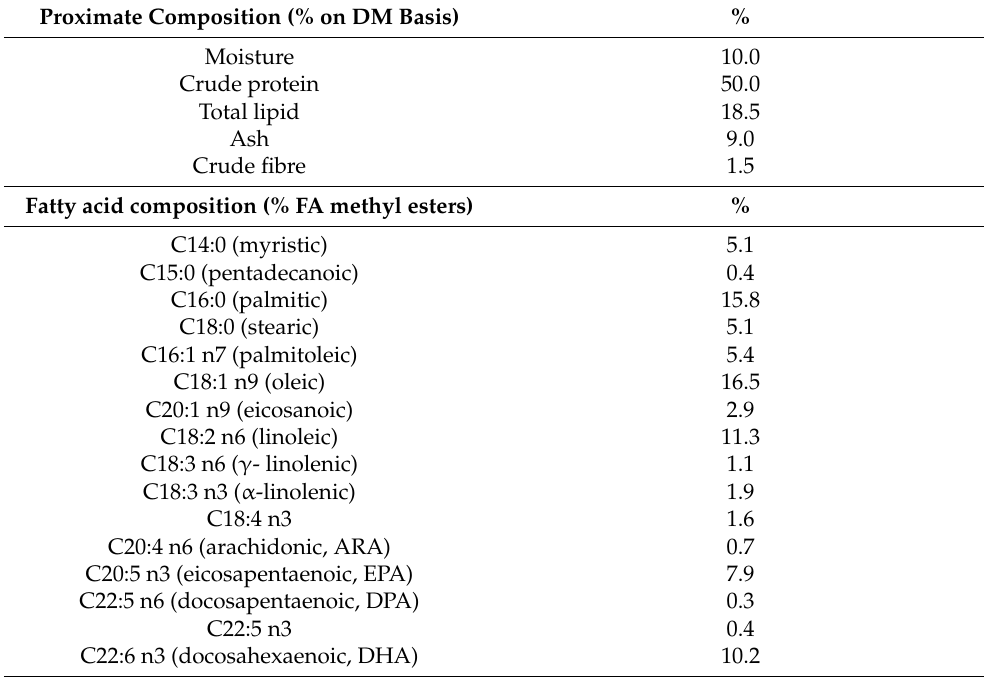
Table 1. Chemical and fatty acid composition of feed (%). Proximate Composition (% on DM Basis) % Moisture 10.0 Crude protein 50.0 Total lipid 18.5 Ash 9.0 Crude fibre